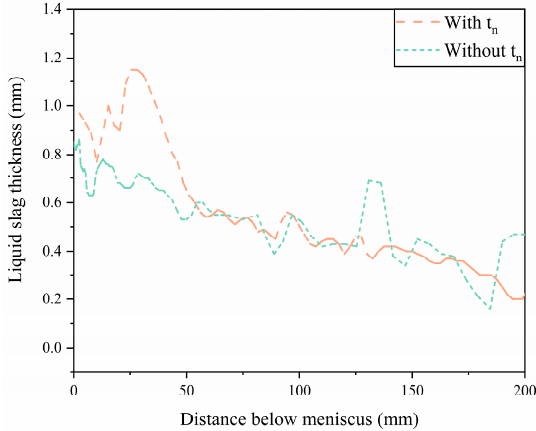
Figure 14. Comparison of the thickness of the liquid slag with and without t n